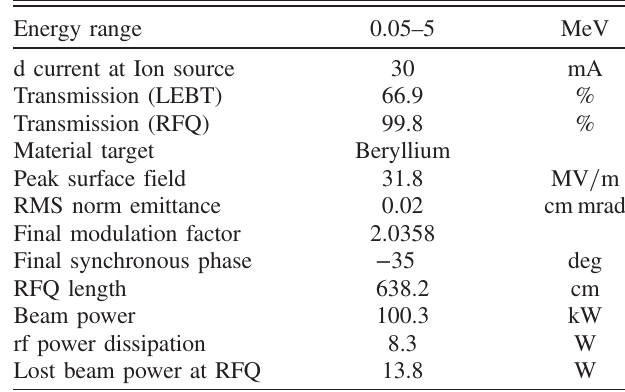
TABLE XII. Conceptual design of SC-RFQ for BNCT with a proton acceleration of 5 MeV.